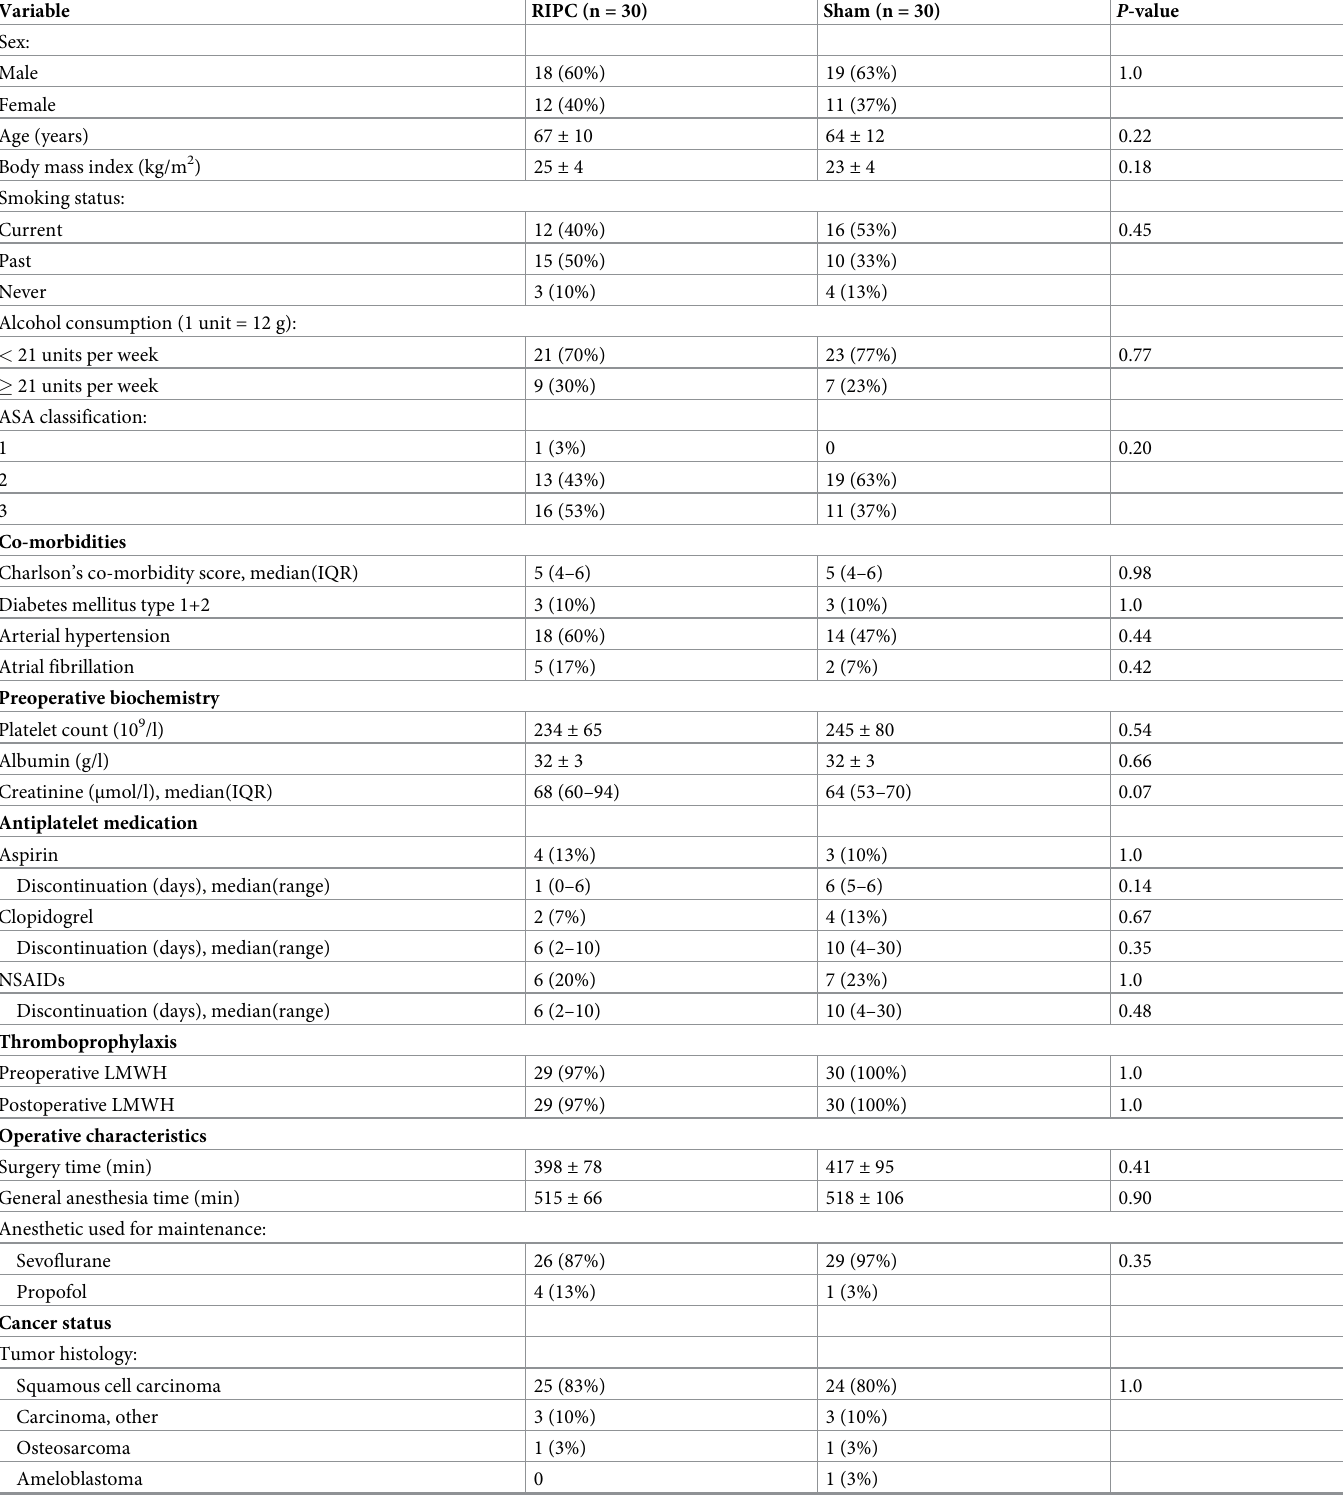
Table 1. Baseline and operative